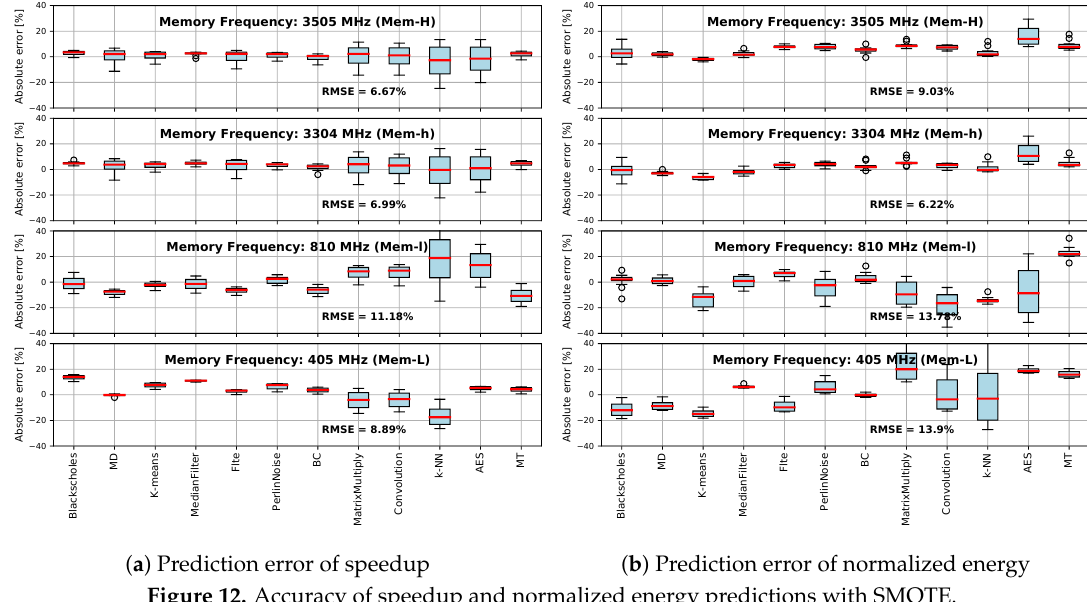
Figure 12. Accuracy of speedup and normalized energy predictions with